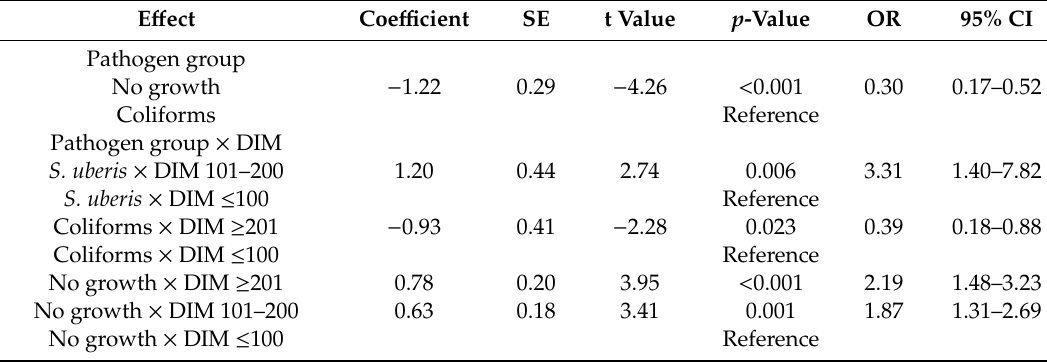
Table 8. Final mixed logistic regression model for full cure of clinical mastitis from 12 di ff erent herds in Northern Germany.